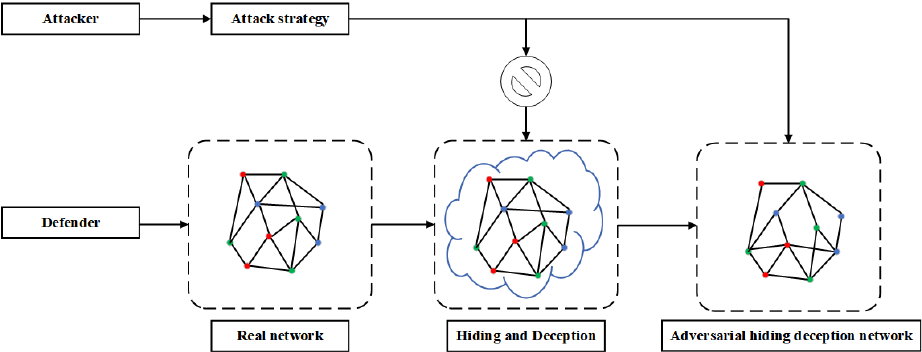
Figure 3. Schematic diagram of the adversarial hiding deception